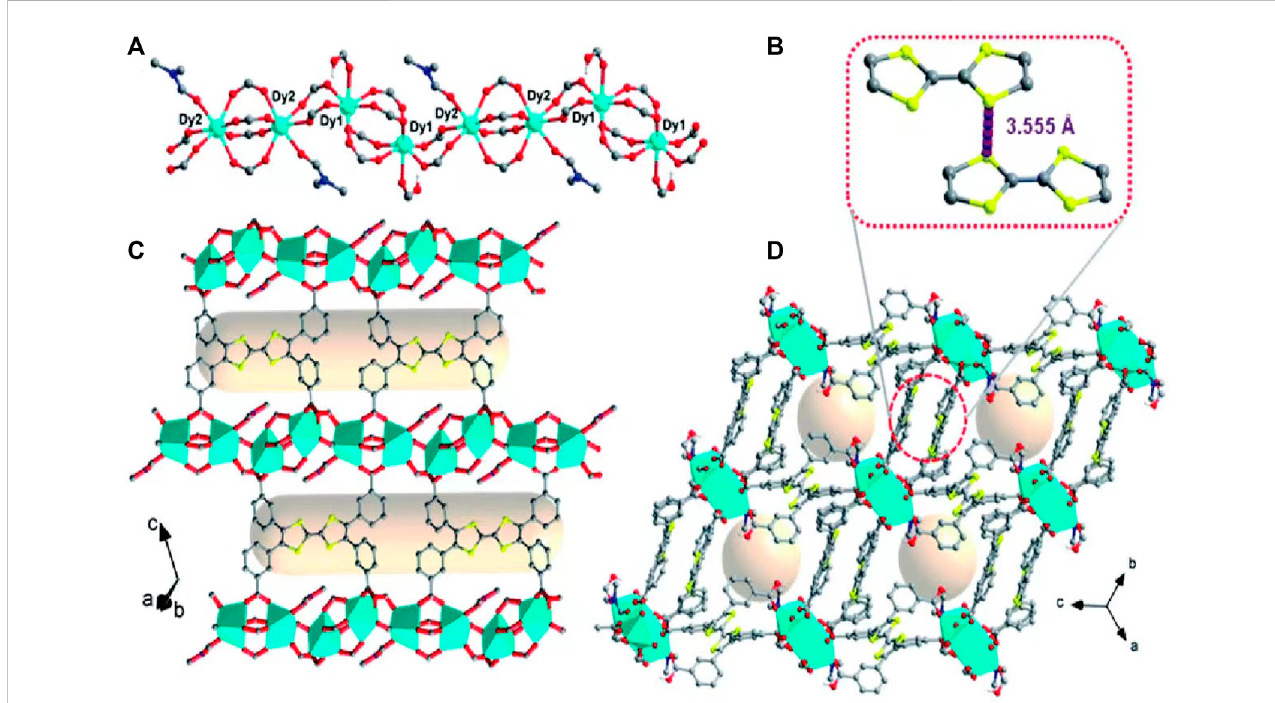
FIGURE 4 Single-crystalstructure ofDy-m-TTFTB. (A) The one-dimensional chainof Dy-m-TTFTB; (B) theweak interaction between TTF (L1)dimers; (C) thetwo- dimensional structureassembledfromtheone-dimensionalchainsandm-TTFTB4-ligands (D) viewofthethree-dimensionalframework.Color scheme:Dy, cyan; O, red; N, blue; C, black or gray; S, yellow; H, green. Reproduced with permission from (Su et al., 2022) Copyright (2022) Royal Society of